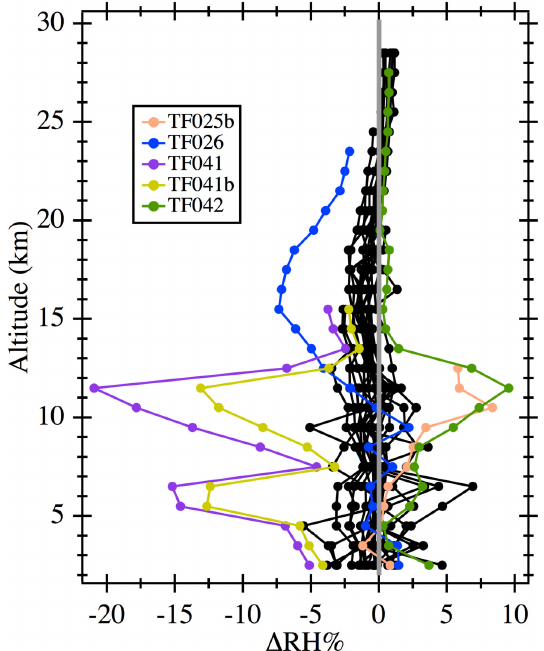
Fig. 13. Statistics of 1 RH for RS92-RS92 (red) and FP RS92 - FP IMET (black) in 5-km altitude bins. Each of the symbols rep- resents the same statistics of differences described for Fig. 5. For FP RS92 -FP IMET 1 RH there are statistically significant biases in the 10–15 and 15–20km bins and median differences in the 0–5 and 5– 10km bins that are statistically different from zero. Median and mean RS92-RS92 1 RH are statistically different from zero in the 0–5 and 25–30km bins, respectively.